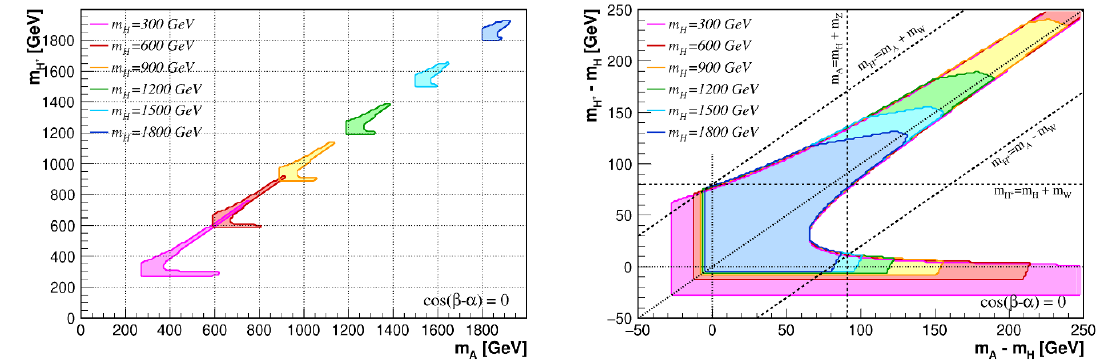
Figure 1 . Allowed regions in parameter space of m A vs. m of m A (cid:0) m H vs. m (cid:0) m H (right panel) considering electroweak constraints, unitarity and H (cid:6)